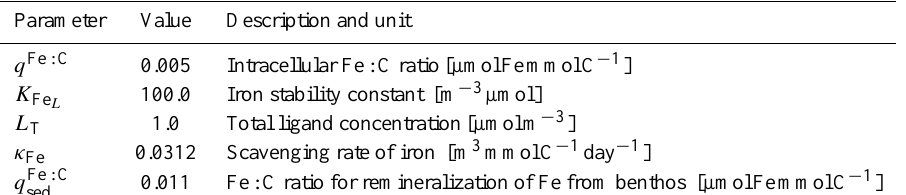
Table A6. Parameters for iron